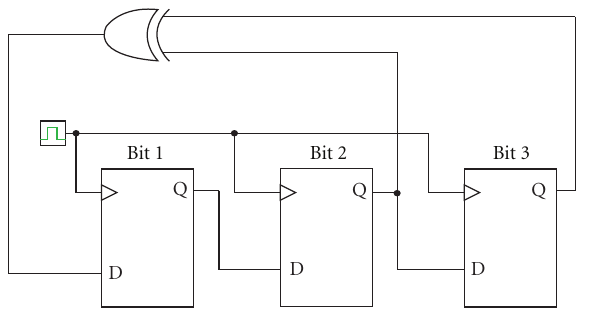
Figure 1: Schematic of a maximal length 3-bit linear feedback shift register.